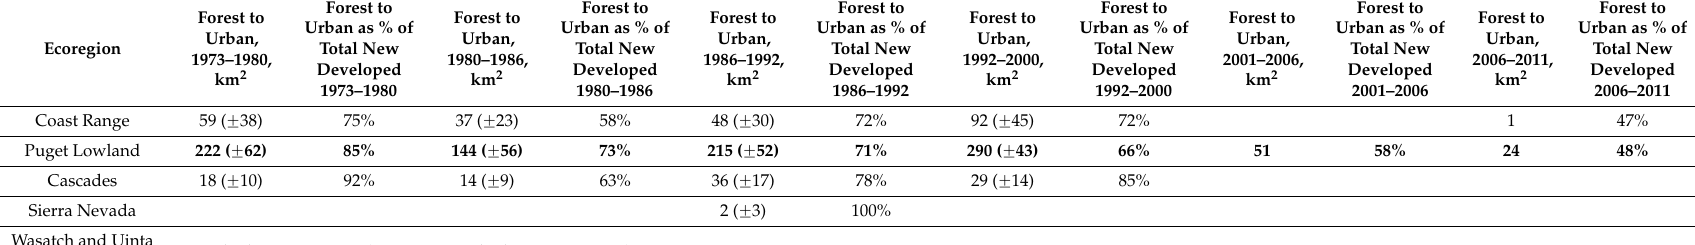
Table 1. Ecoregions with forest as a substantial source of new development in any or all time intervals (all time intervals in bold). Ecoregions where at least 40% of new developed land cover came from